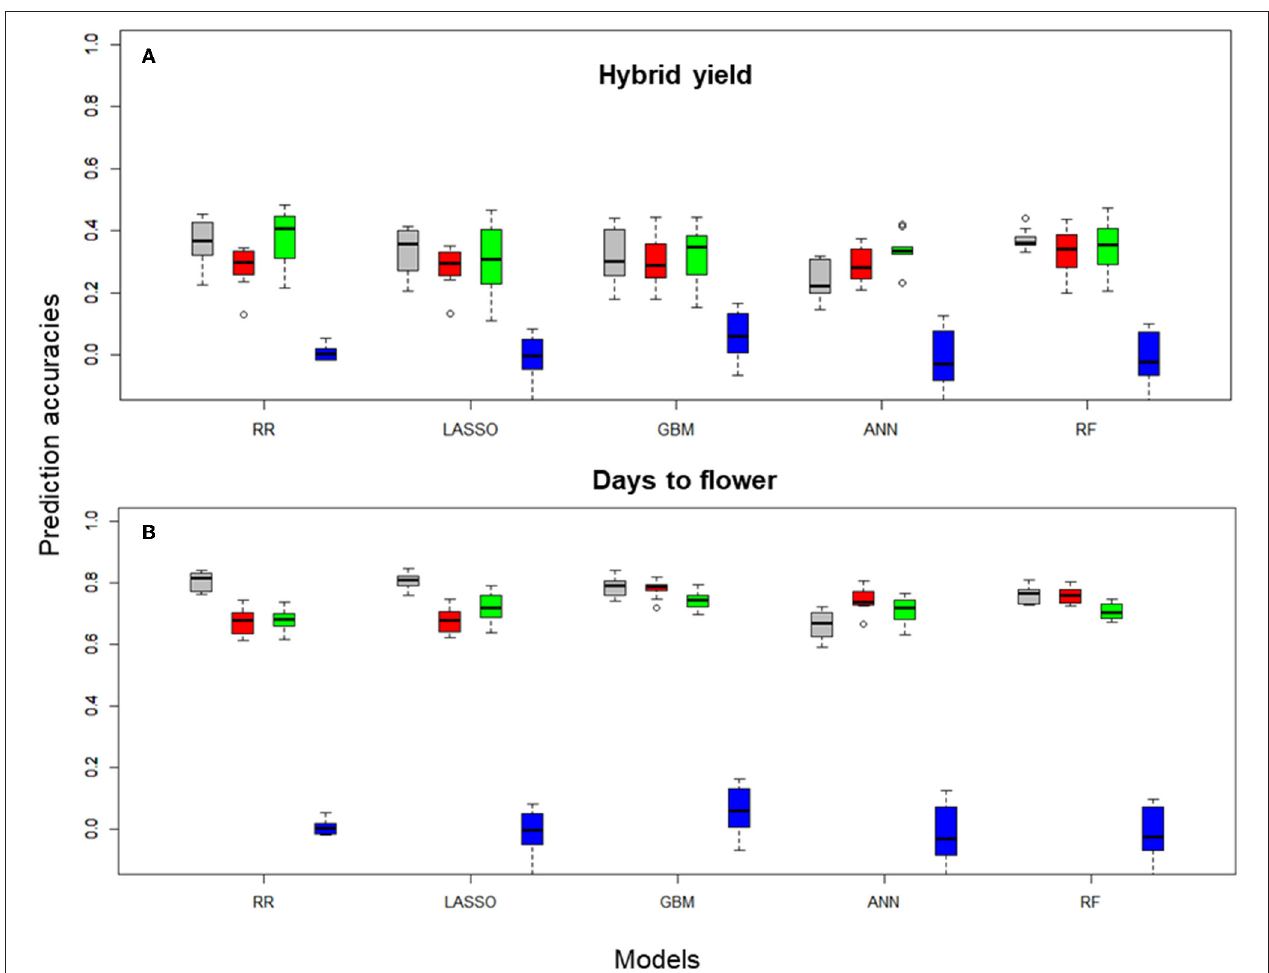
FIGURE 2 | Boxplots for (A) hybrid yield and (B) days to flower predictions of the B. napus data set obtained on 10-fold cross-validation (CV) sets, using Pearson correlations, with rrBLUP, LASSO, GBM, ANN, and RF, with 100, and 1,000 SNP subsets selected with different filter methods and the entire SNP data set (colored in gray). Filter methods: principal component analysis 100 PCA (red), 1,000 RF (green), 1,000 RS (blue), and 14,718 (gray, no FS using the total number of markers after